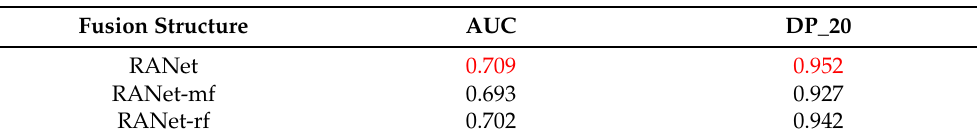
Table 4. AUC score and DP_20 value of three RANet models with different fusion structures. The best results are labeled in the red